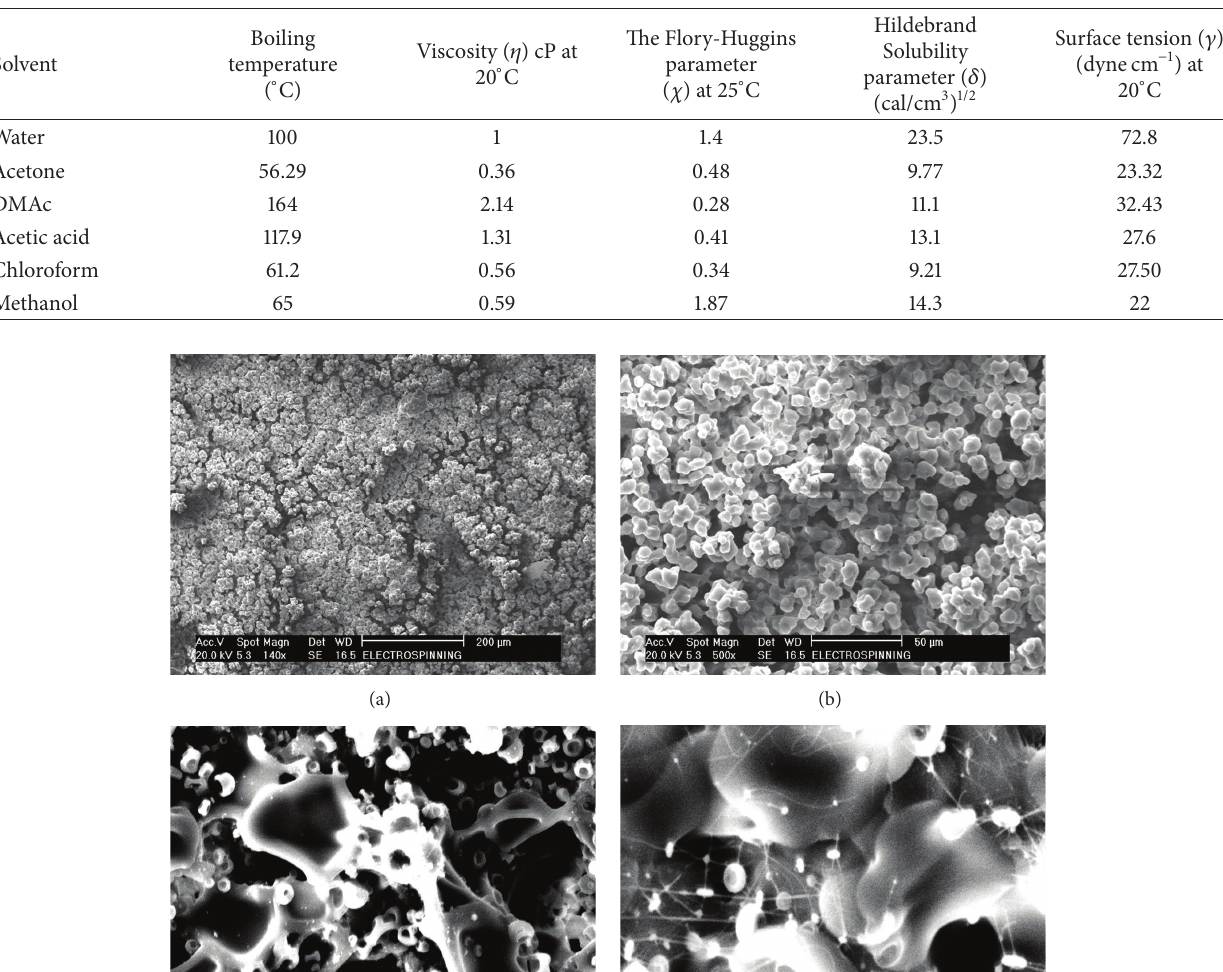
Table 3: Physical properties of solvents [15, 19, 20, 31].